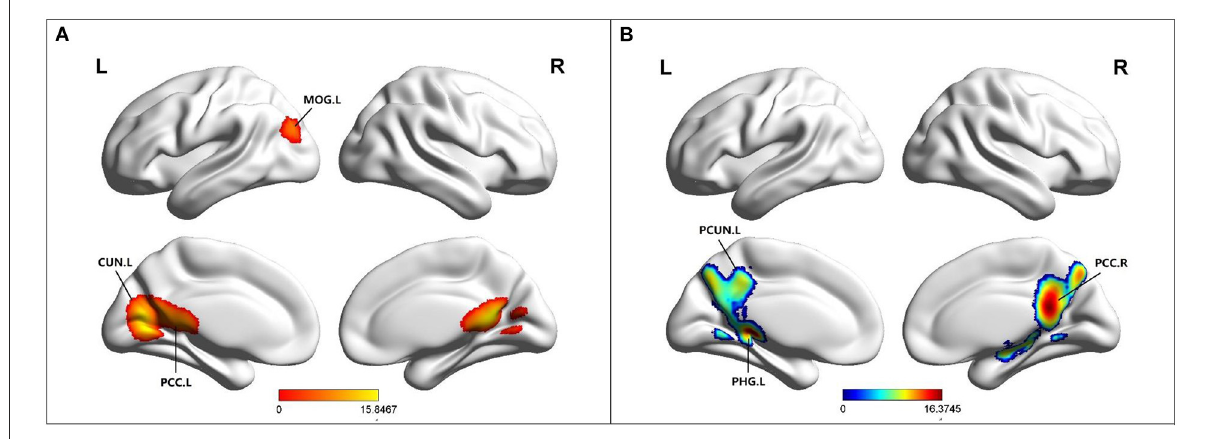
FIGURE2 (A) Brain regions showing increased FC in MCI patients compared to HCs. (B) Brain regions showing decreased FC in MCI patients compared to HCs. MCI, amnestic mild cognitive impairment; HCs, healthy controls; FC, functional connectivity; MOG, middle occipital gyrus; CUN, cuneus; PCC, posterior cingulate; PCUN, precuneus; PHG, parahippocampal gyrus; R, right; L, left.